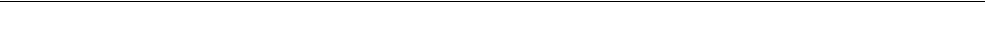
Table 5. Results of Fisher Exact Test for Food Security Status Change and Social Identity Factors